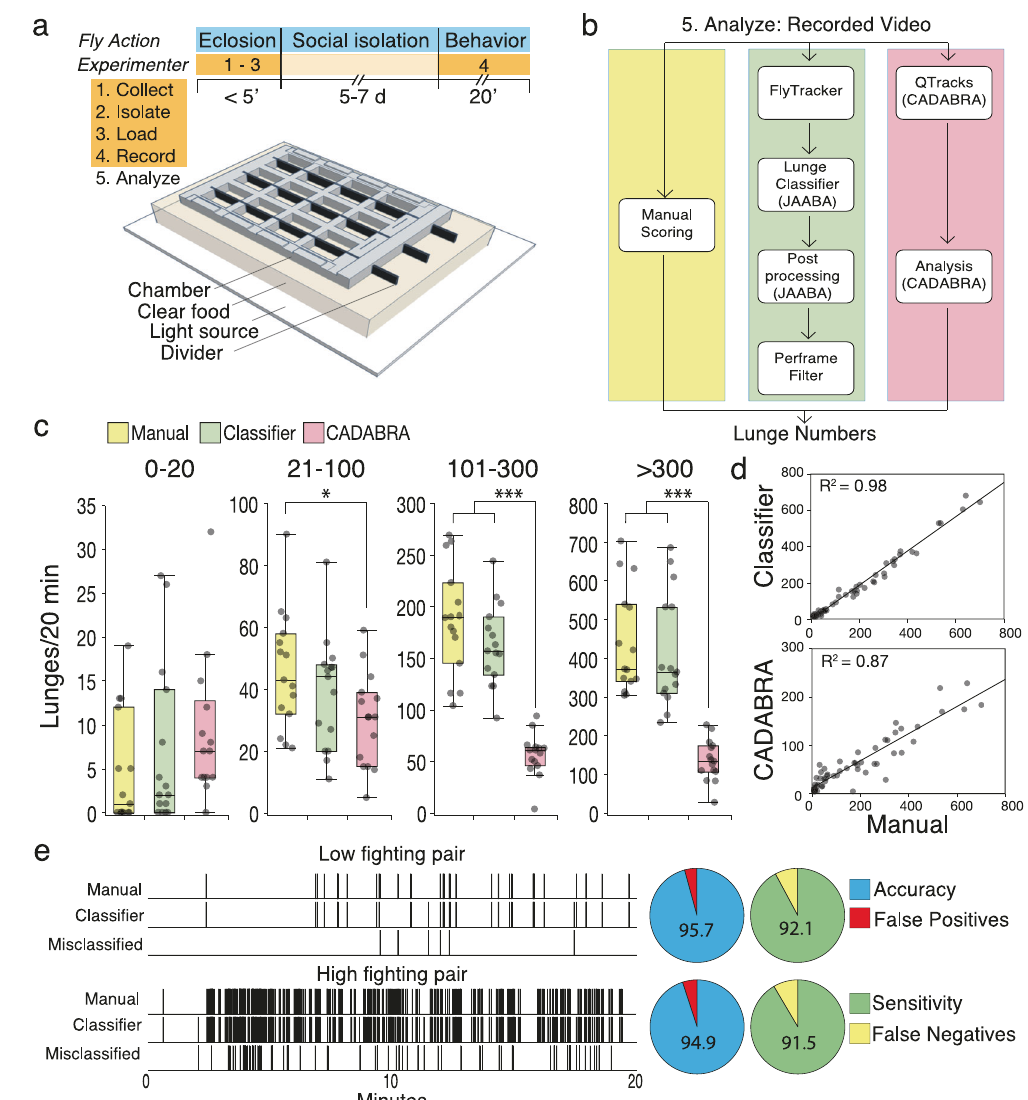
Fig. 1 Divider Assay for precise quanti fi cation of aggression over a broad range of fi ghting intensities. a Schematic of the Divider Assay setup and experimental time line. Collecting, isolating, and loading fl ies are done in one step under 5 min. Flies are then isolated on clear food until they are videotaped. b Recorded video analysis can be done manually (yellow), with a newly developed JAABA-based classi fi er to precisely score lunges (green), or with existing CADABRA software (red). c Sixty pairs of fl ies with lunges ranging from 0 to 700 were analyzed manually, with a new JAABA-based classi fi er, and CADABRA. For this analysis, four groups of fi ghting intensities were chosen: 0 – 20, 21 – 100, 101 – 300, and >300 lunges. The JAABA-based classi fi er performed close to the gold standard with no signi fi cant differences in any group (Kruskal – Wallis ANOVA with Dunn ’ s test and Bonferroni correction 0 – 20, p = 1.0; 21 – 100, p = 0.55; 101 – 300, p = 0.75; >300, p = 1.0, n = 15 per group). CADABRA tended to overscore low fi ghting fl ies, but signi fi cantly underscored high fi ghting pairs (Kruskal – Wallis ANOVA with Dunn ’ s test and Bonferroni correction, 0 – 20: p = 0.08, n = 14; 21 – 100: p = 0.03; 101 – 300: p < 0.0001; >300: p < 0.0001, n = 15 per group) (see also Supplementary Fig. 1, for Gardner – Altman estimation plots). d Regression analysis between manual scoring and classi fi er ( R 2 = 0.98, p < 0.0001, n = 60) or CADABRA ( R 2 = 0.87, p < 0.0001, n = 59) are both highly signi fi cant. e Misclassi fi ed lunges with the JAABA-based classi fi er occur at low frequency in both low and high fi ghting pairs (false positives ~5% and false negatives ~8%). Boxplots show the median, fi rst and third quartiles as boxes, with whiskers representing the 5 and 95% different methods currently used in the fi eld. Our standard chamber is 4.5 mm high to afford fi ghting fl ies enough space to stand up on their hindlegs, which is common during aggressive interactions. The chamber contains an array of 4 × 3 square arenas of ~1.3 cm wide (1.69 cm 2 ).